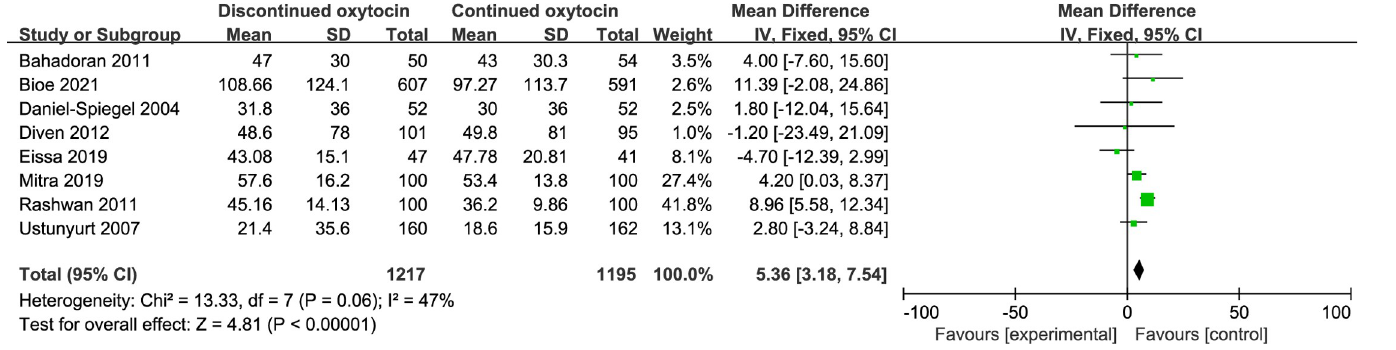
Fig 12. Pooled results for each outcome.